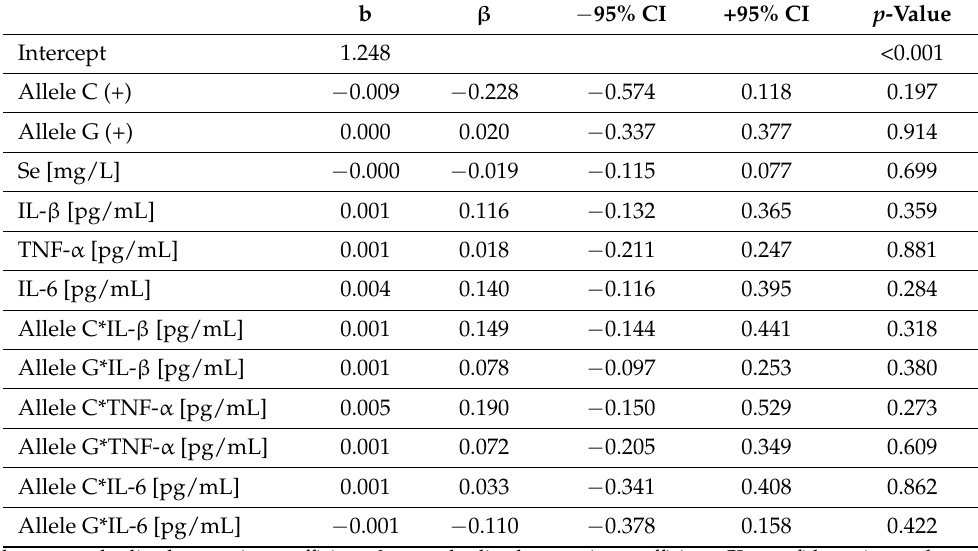
Table 12. Model II with moderation by the